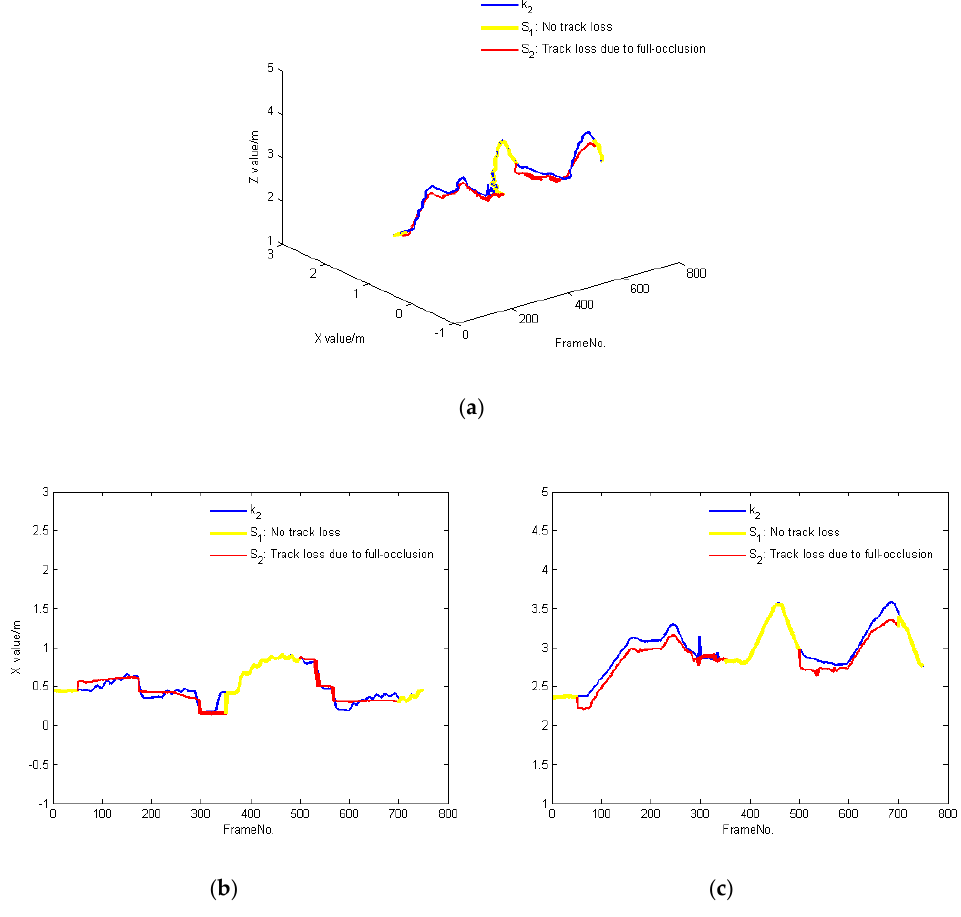
Figure 15. Comparison between trajectories as tracked by a person’s skeleton and via their shadow when H b moves in the tracking area, ( a ): The trajectories of a person B walking at random, ( b ): X value of the trajectories respectively at various speeds, ( c ): Z value of the trajectories respectively at various